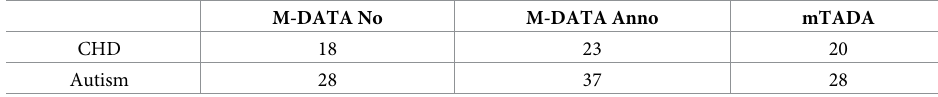
Table 3. Comparison of M-DATA multi-trait models with